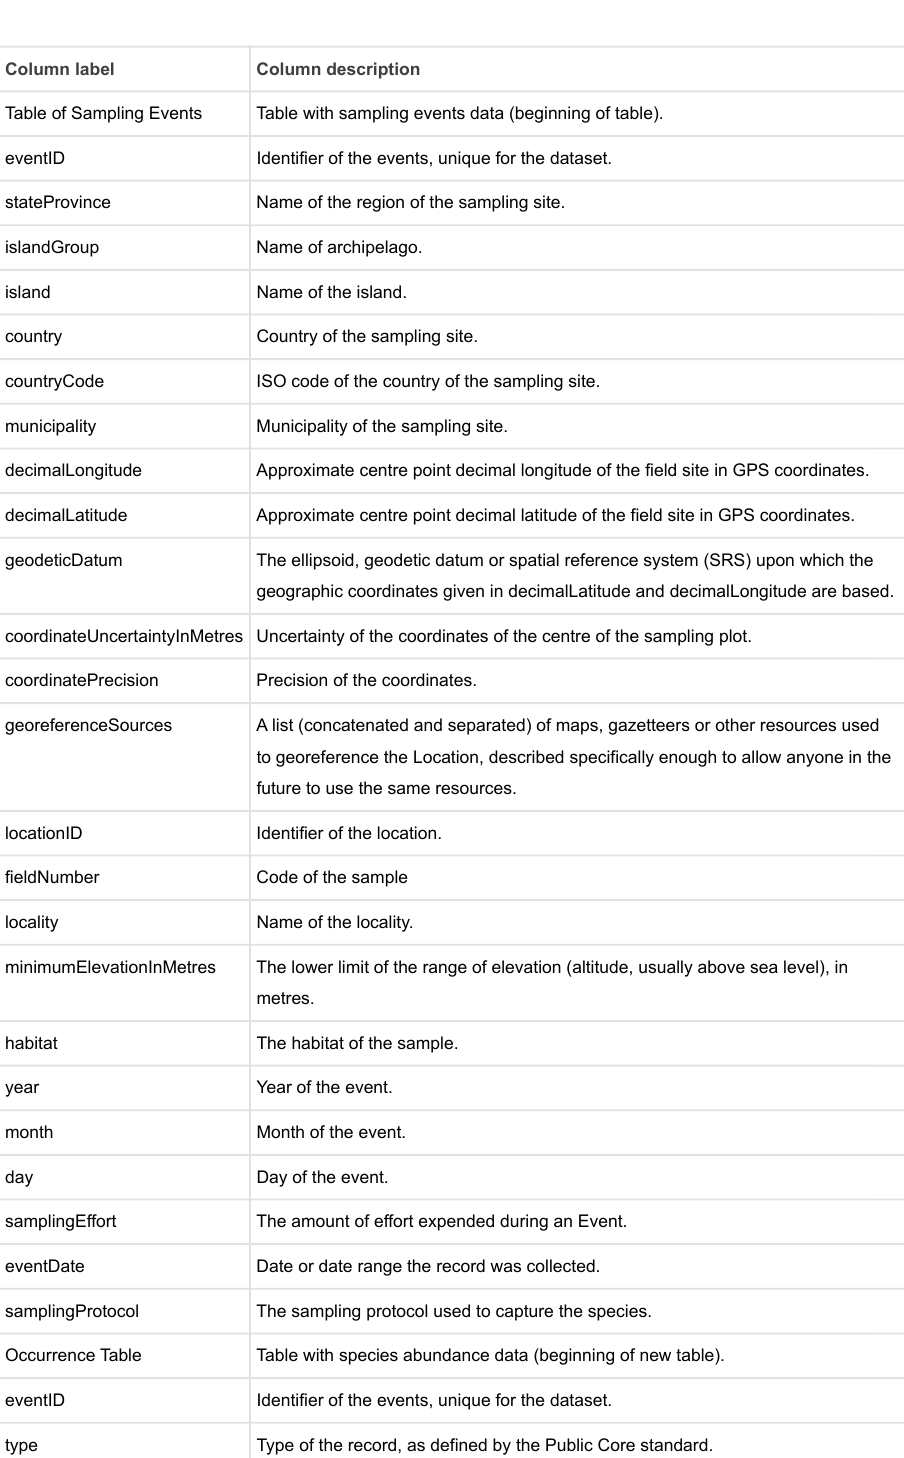
Table with species abundance data (beginning of new